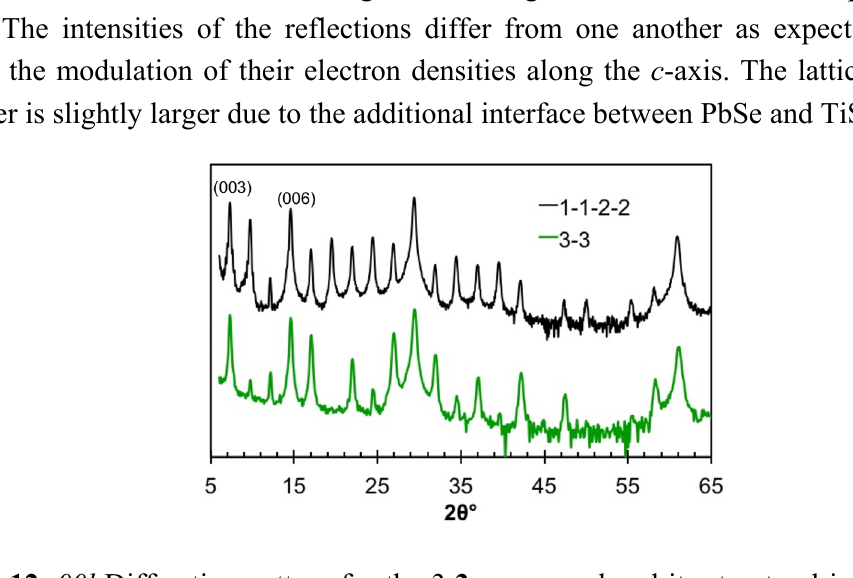
Figure 12. 00l Diffraction pattern for the 3: 3 compound and its structural isomer 1: 1 :2: 2 . Differences in layering scheme result in changes to the relative intensity of diffraction